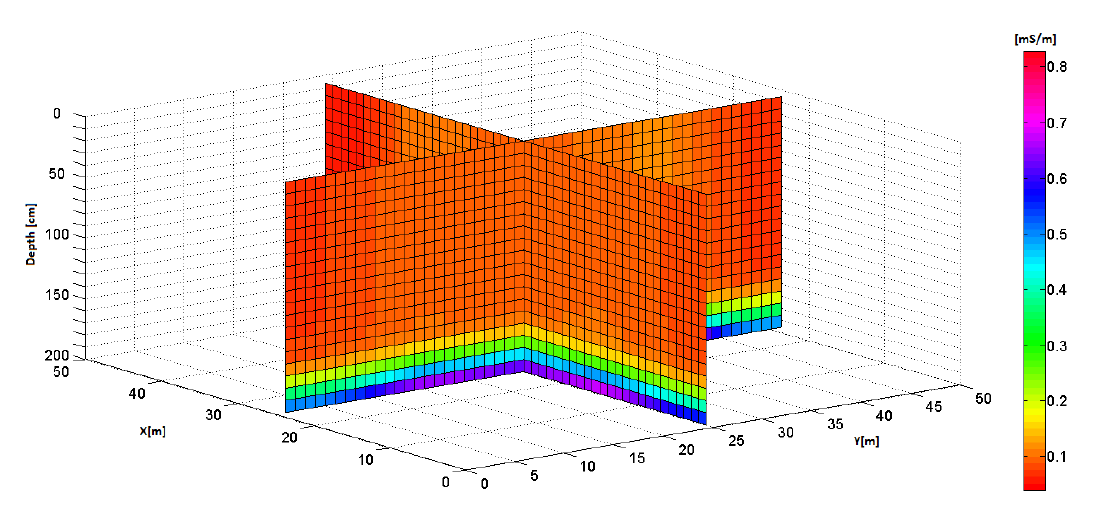
Figure 11. Electrical conductivity section in sand soil textures.